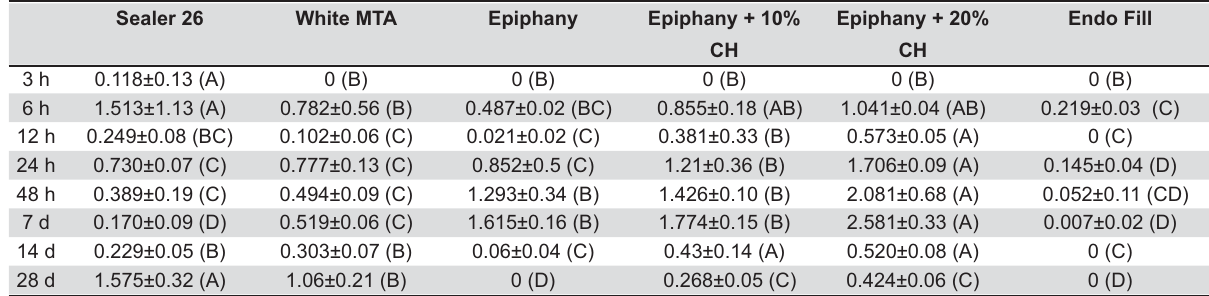
(A,B,C,D) In each period, means values followed by different labels are statistically different